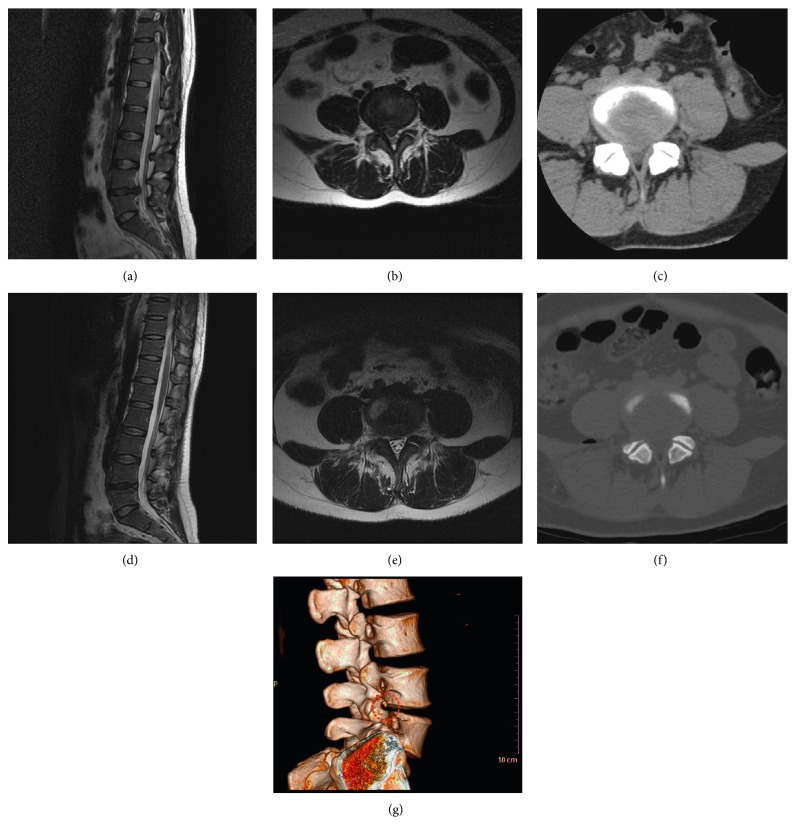
The preoperative and postoperative imaging data of patient who received TF PELF. (a and b) A preoperative MRI image shows the sagittal and coronal views of a patient diagnosed with LDH. (c) A preoperative CT image of the same patient. (d and e) The postoperative MRI sagittal and coronal views of the patient after TF PELF. (f) A postoperative CT image. (g) The postoperative 3D CT imaging result. The red round denotes foraminoplasty.